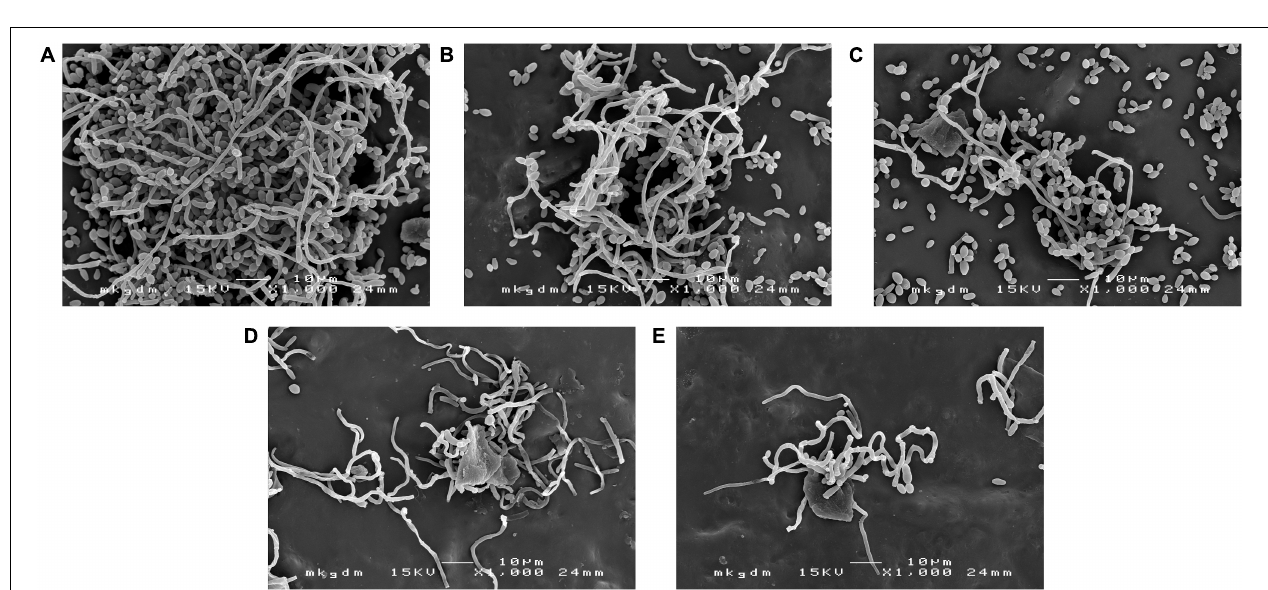
FIGURE 6 | CLSM images of biofilms on untreated (A) or free AMB (B) , CSNPs-AMB (C) , AMB+Gls (D) , and CSNPs-AMB-Gls (E) treated silicone surfaces. Biofilms were stained with the Live/Dead R (cid:13) BacLight TM Bacterial Viability and Counting kit. CLSM reconstructions show the three-dimensional staining pattern for live cells (SYTO-9, green) and dead cells (propidium iodide, red). Magnification, × 10.